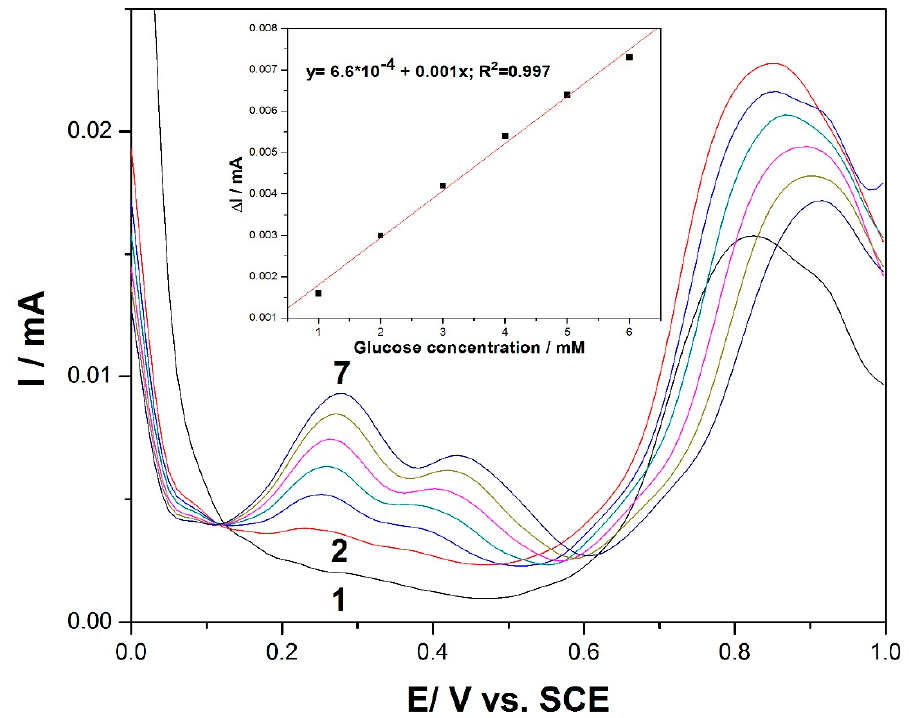
Figure 5. Differential pulse voltammetry (DPV) recordings at the MWCNT-CuBTC composite electrode in 0.1 M of NaOH supporting electrolyte (curve 1) and in the presence of various glucose concentrations from 1 mM to 6 mM (curves 2–7) under the following operating conditions: MA of 0.002 V and SP of 0.01 V. The inset shows the calibration plots of the current, recorded at +0.27 V/SCE versus the glucose concentration.